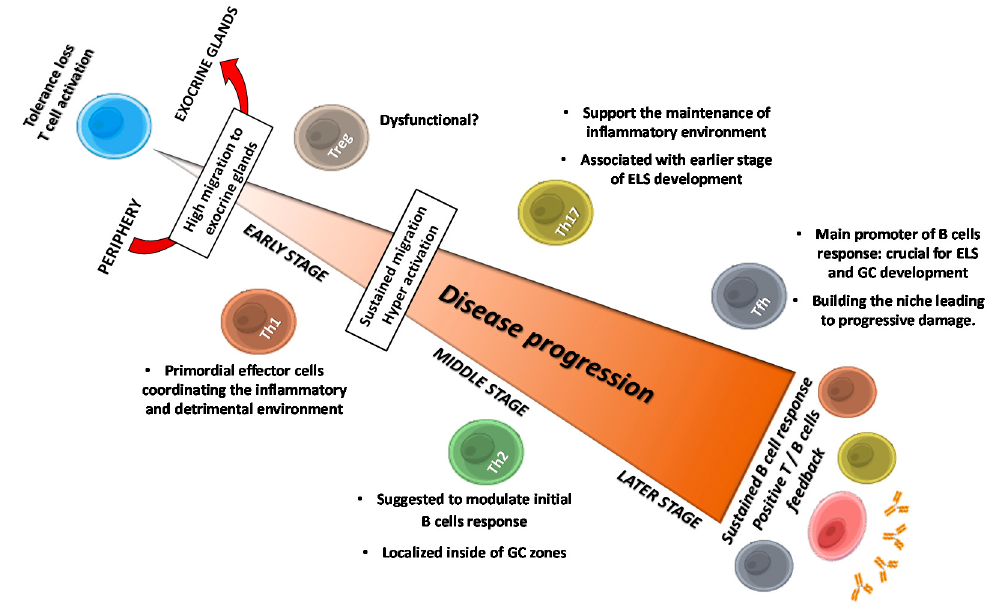
Figure 1. Sequential roles of T cells in SS progression: flares of main implications. Tolerance loss drives T cell activation and migration to exocrine glands, where they provide several factor that make the auspicious environment for the pathology establishment: Th1 and Th17 cells contribute for inflammatory and detrimental environment by secreting cytokines like IFN- γ , TNF- α and IL-17, triggering sustained T cells migration and hyperactivation. Th2 cells are suggested to modulate early B cells response, and to contribute with Th17 cells in initial ESL development, allowing Tfh cells to establish and to provide the necessary factors to trigger B cells response; thus, leading to progressive tissue damage. Treg cells dysfunctionality and low frequency are suggested to contribute to periphery loss tolerance. Positive T and B cells feedback trough intercellular contact and soluble factor allow a sustained B cells response and the onset of clinical features. GC, Germinal Center; ELS, Ectopic Lymphoid Structures.